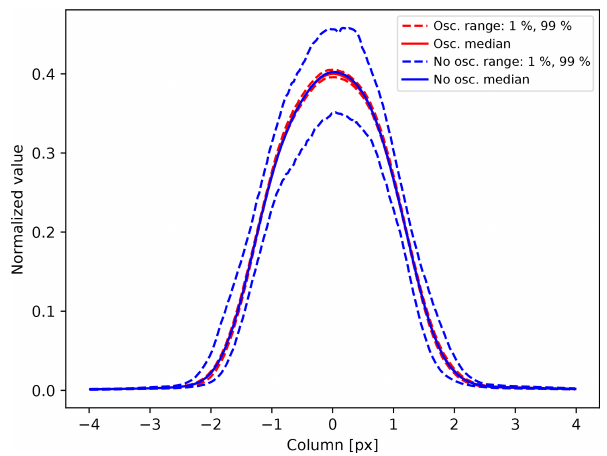
Figure 19. Median dark current as a function of time.